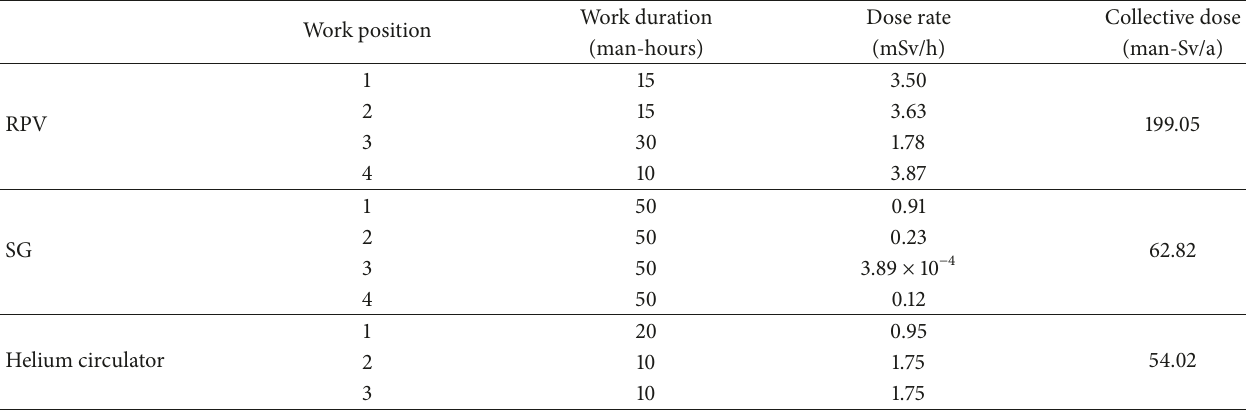
Table 3: The annual work durations and dose rates of RPV, SG, and helium circulator. Work position